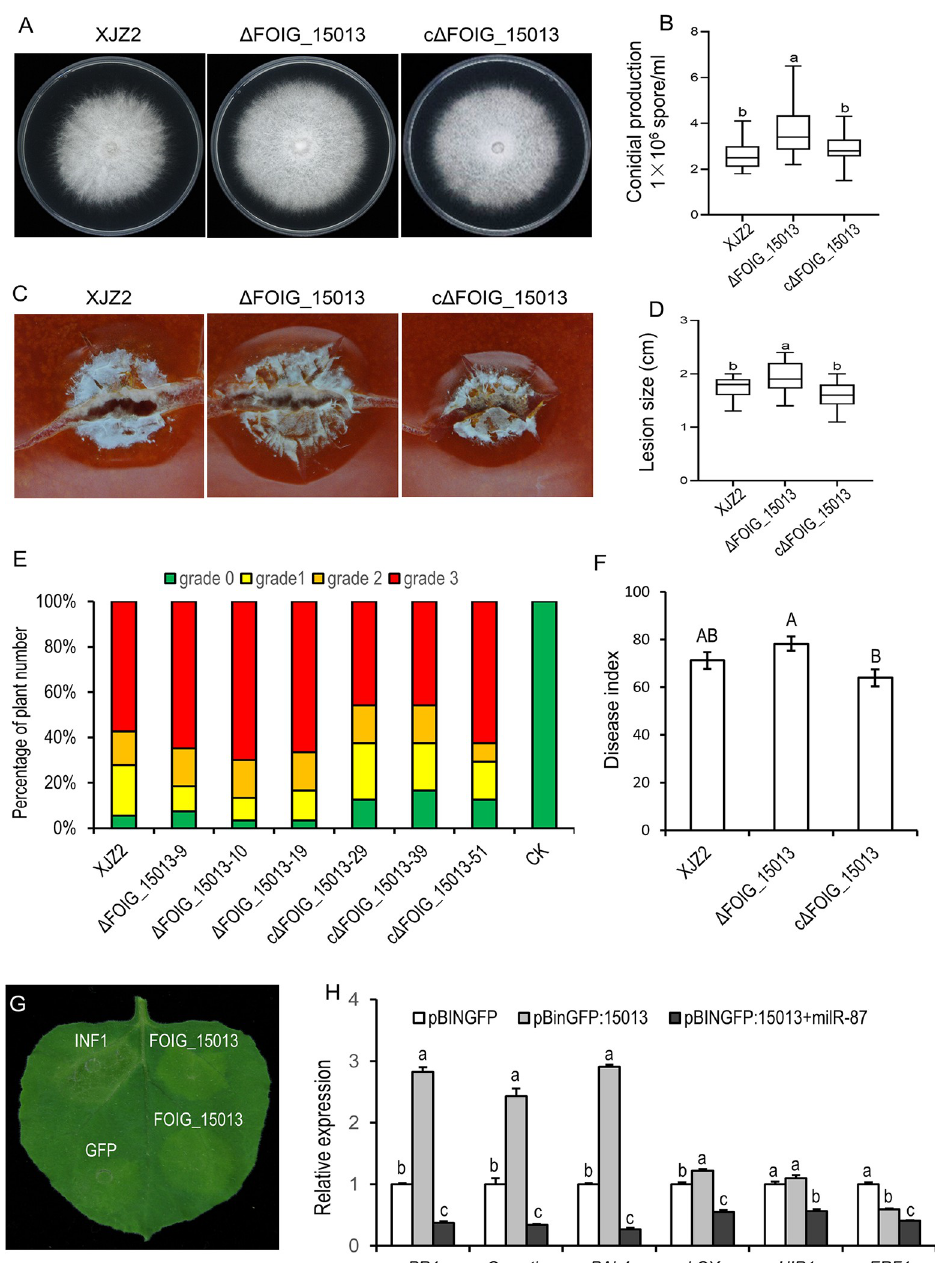
Fig 8. Investigation of FOIG_15013 function in Foc growth, conidiation, and pathogenicity. ( A ) Colony morphology of the WT strain XJZ2, FOIG_15013 deletion mutant ( Δ FOIG_15013 ), and complemented transformant (c Δ FOIG_15013 ). ( B ) Conidial production of the tested strains. ( C ) Symptom of necrosis caused by the tested strains on the surface of tomato fruits. ( D ) Statistical analysis of the lesion size on the surface of tomato fruits. ( E ) Disease severity analyzed by percentage of amount of diseased host banana seedling with different disease grade. ( F ) Disease index. Three Δ FOIG_15013 mutants, three complemented strains (c Δ FOIG_15013 ) and the WT strain XJZ2 were used for the pathogenicity test. A total of 30 banana seedlings were used for every tested strain. Duncan’s multiple range test was used for statistical analysis and different capital letters indicate significant difference at the level of α = 0.05. Error bars indicate S.D. (n = 3). ( G ) Hypersensitive response induced by transient expression of FOIG_15013 in N . benthamiana leaves. Leaves of N . benthamiana were infiltrated with Agrobacterium tumefaciens carrying pBIN::GFP- FOIG_15013 . Photographs were taken at 2 days post-agroinfiltration. INF1 and GFP were used as positive and negative control, respectively. ( H ) Transcript levels of defense responsive genes induced by transient expression of FOIG_15013 in N . benthamiana . The constitutively expressed gene NbEF1 α was used as internal reference [33]. Different letters indicate significant difference at the level of α = 0.01. Error bars indicate S.D. (n = 3).